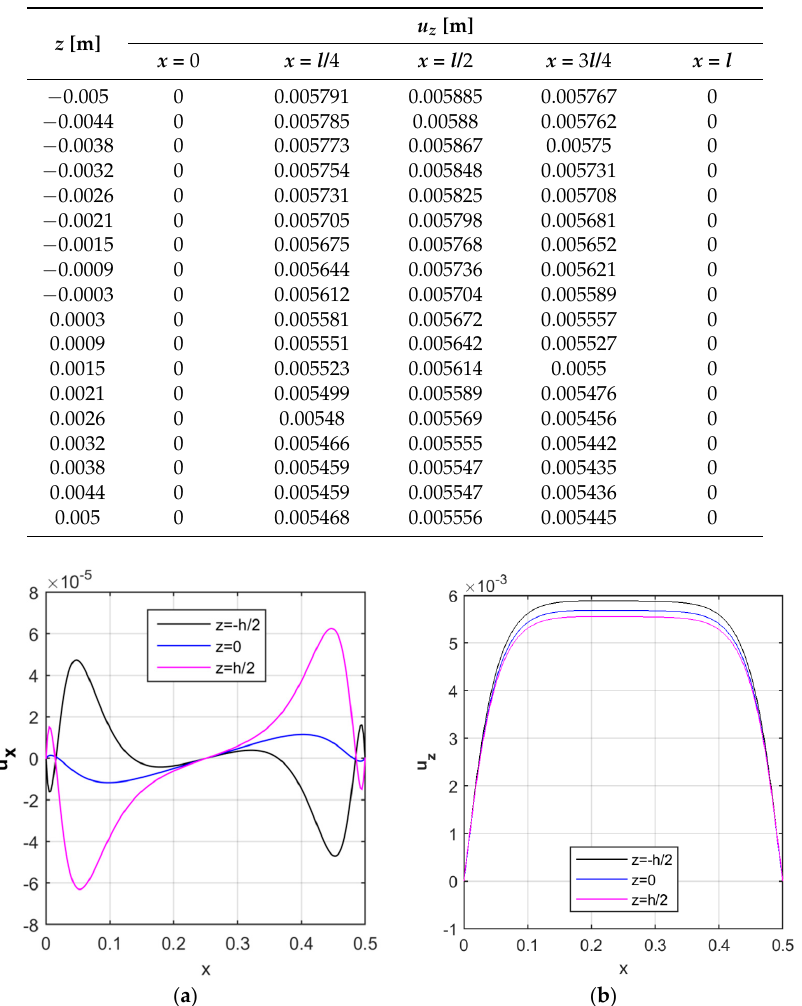
Table 4. Variation of the radial displacement field along the radial direction at different longitudinal positions.